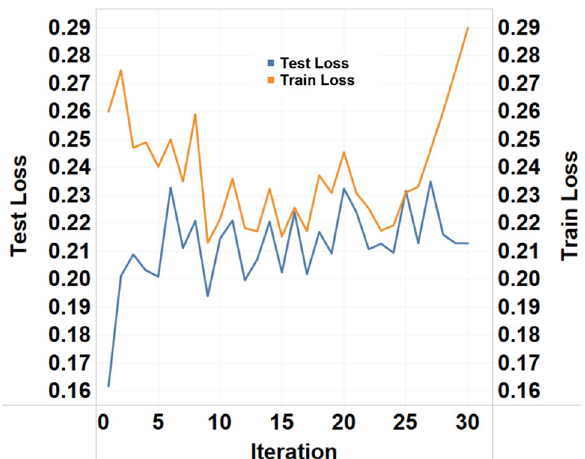
Figure 6. Test and train loss function plotted for every iteration. The last point on the iterations shows the optimized combination of